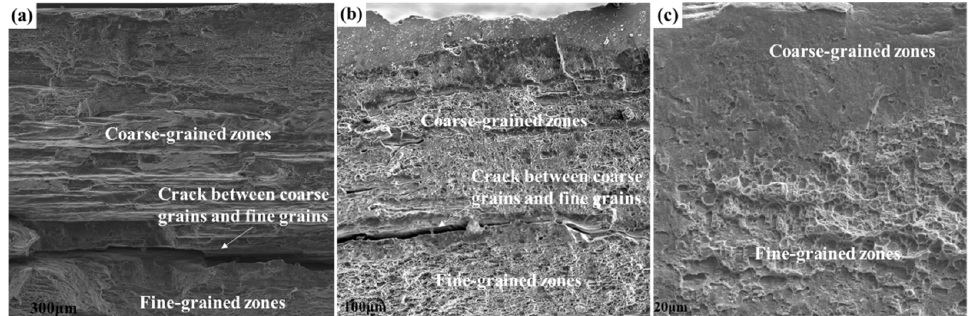
Figure 7. Tensile fracture images of Ot specimens of three different plates near the surface: ( a ) ASP; ( b ) DSP; ( c ) TDSP. ( b ) DSP; ( c )